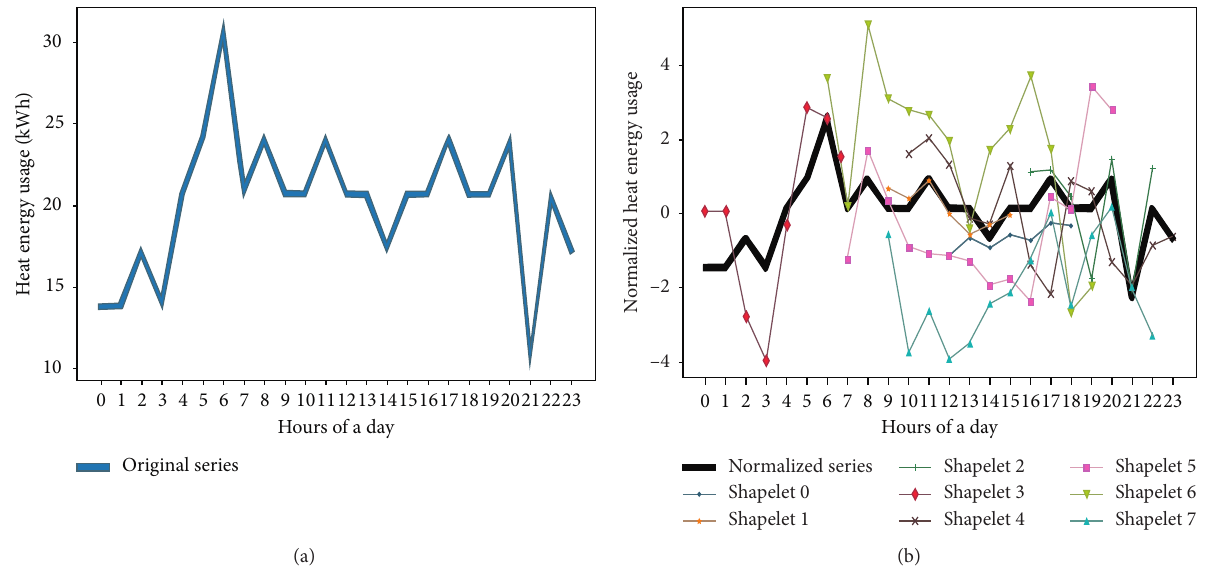
Figure 2: Sample case one (night setback profile): morning peak at 6 a.m. and evening dip at 9 p.m.